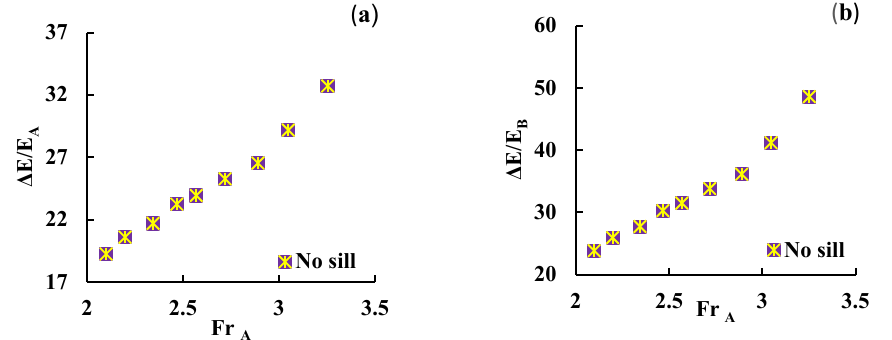
Figure 4. Energy loss compared to the ( a ) upstream and ( b ) downstream sections of the jump.